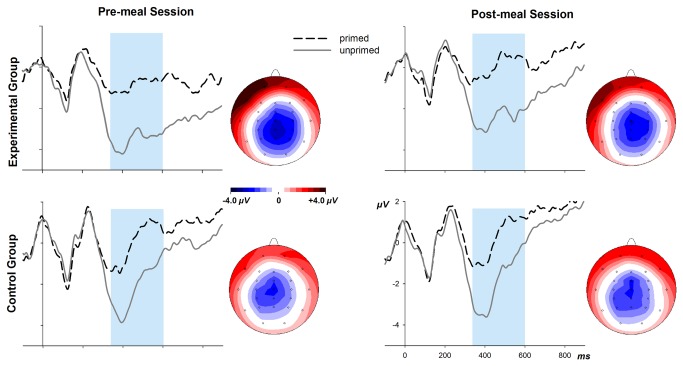
ERPs from the semantic memory task at electrode Cz, superimposed for primed and unprimed target words in the pre-meal (left panel) and post-meal sessions (right panel) and for the Experimental and Control Group (top vs. bottom panels).Also shown are scalp topographies of the difference waves between ERPs to semantically unrelated and related targets words, displaying the distribution of the N400 in the time window 350 – 600 ms.